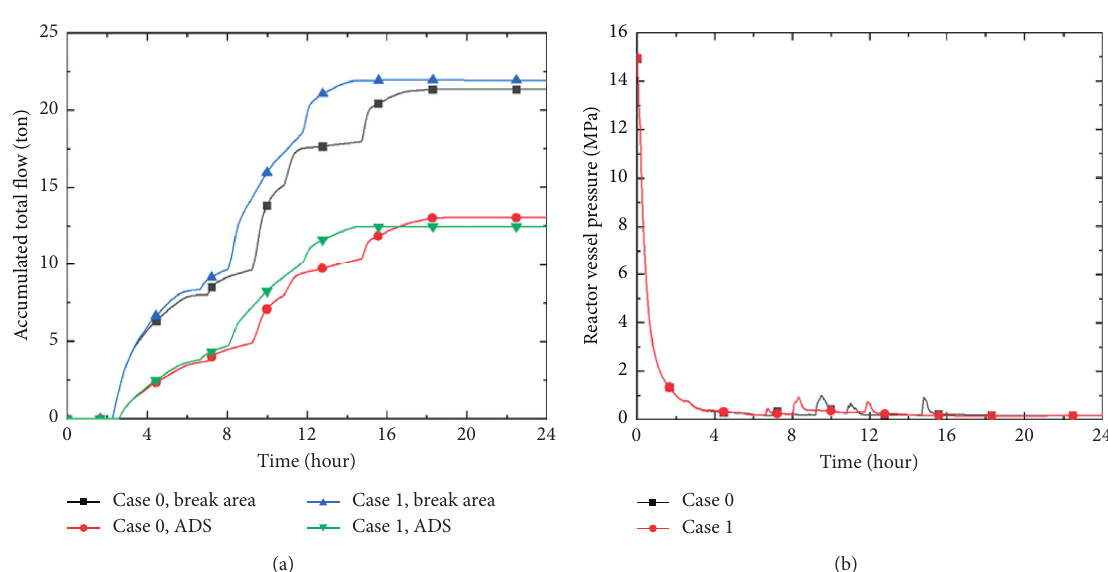
Figure 9: (a) Total accumulated flow through the break area and the automatic depressurization system from the reactor vessel from the start of gap release; (b) pressure in the reactor